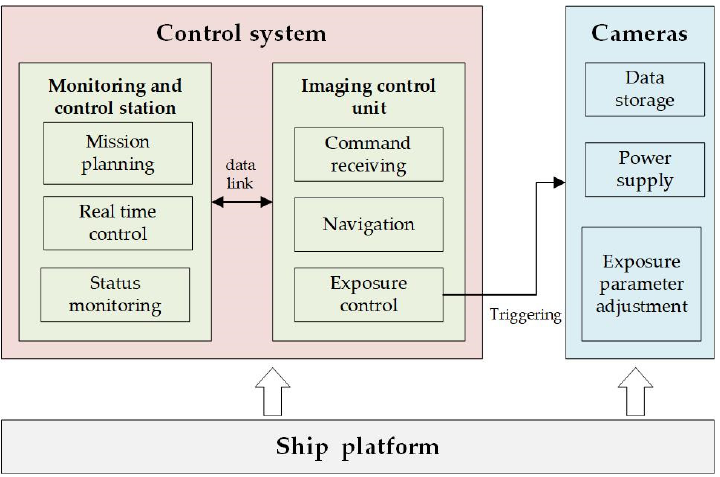
Figure 3. Composition of the shipborne mobile photogrammetry system.